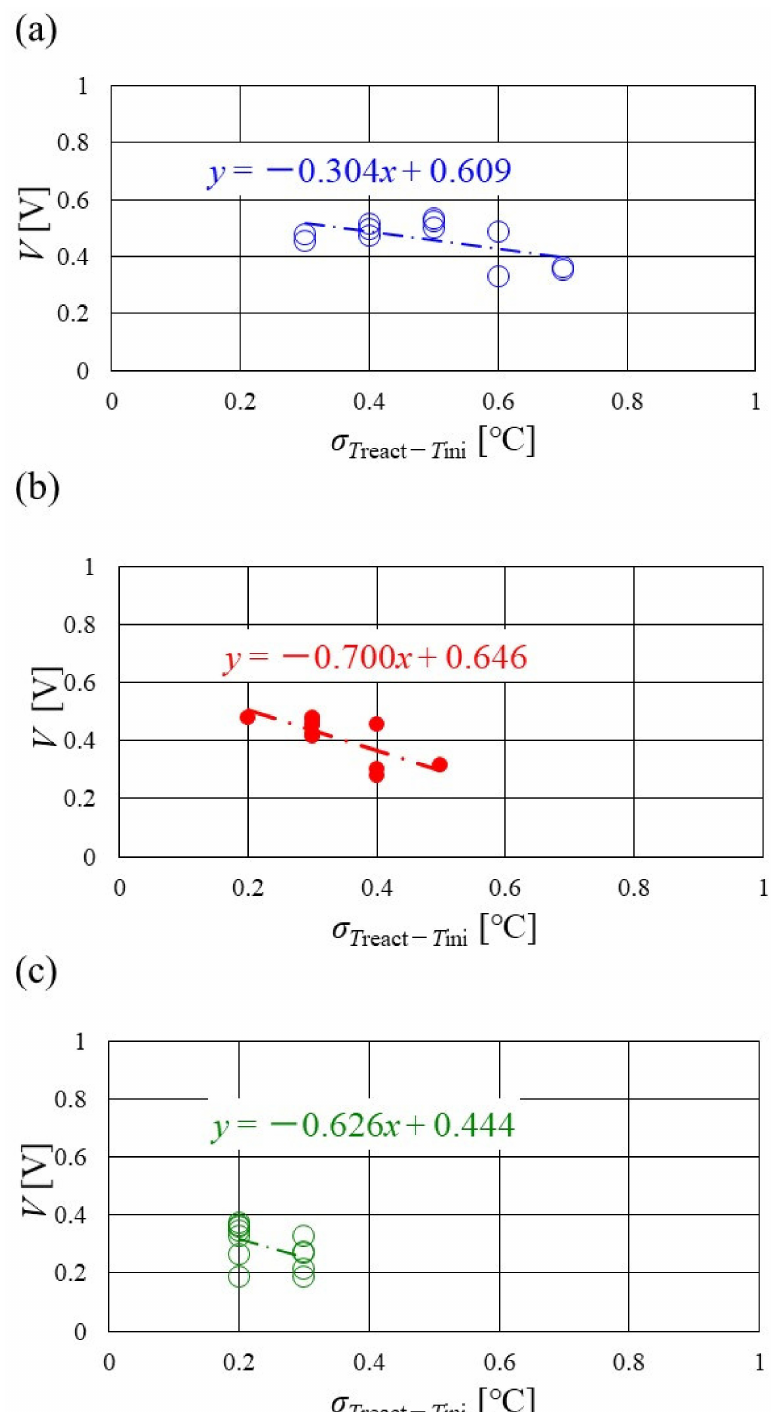
Figure 18. Relation between standard deviation of distribution of temperature difference, between temperature at reaction surface and initial operation temperature and total voltage, in the case of a separator thickness of 1.0 mm: ( a ) the initial operation temperature = 80 ◦ C, ( b ) the initial operation temperature = 90 ◦ C, ( c ) the initial operation temperature = 100 ◦